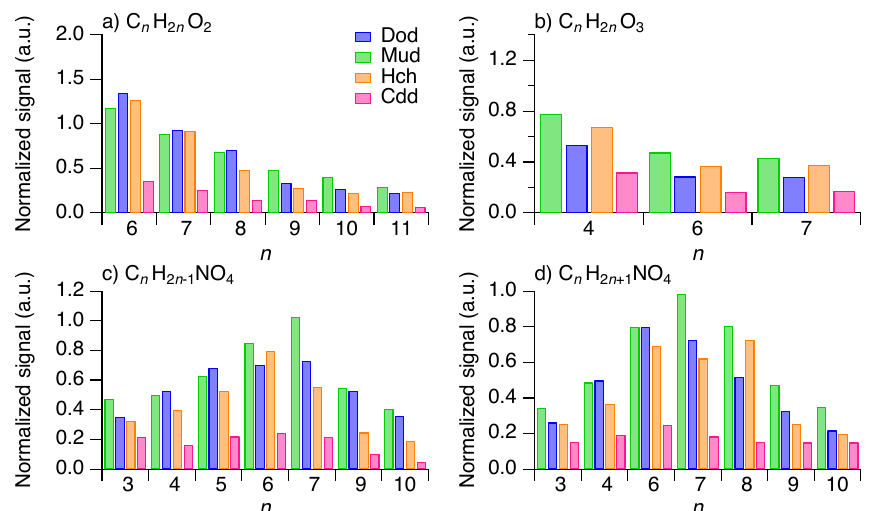
Fig. 8. Comparison of gas-phase fragmentation reaction products from high-NO x alkane photooxidation measured by the CIMS. The signal is normalized by the mixing ratio of alkane reacted. All molecular formulae are proposed assignments. The data represent a 30min average of gas-phase species after 95–100% of the initial alkane had reacted. The ions monitored and their proposed chemical assignments are given in Table S3. The data presented are from experiments DH3, MH2, HH2, and